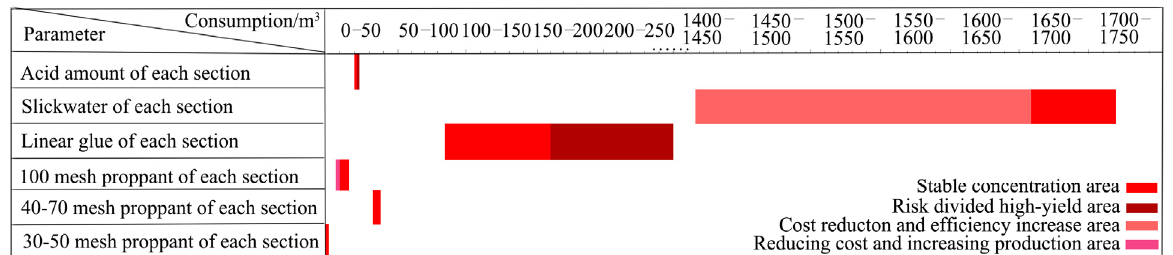
Figure 9. Analysis of 30/50 mesh proppant data. ( a ) Scatter plot of 30/50 mesh proppant; ( b ) violin plot of 30/50 mesh; ( c ) binary KDE plot of 30/50 mesh proppant.